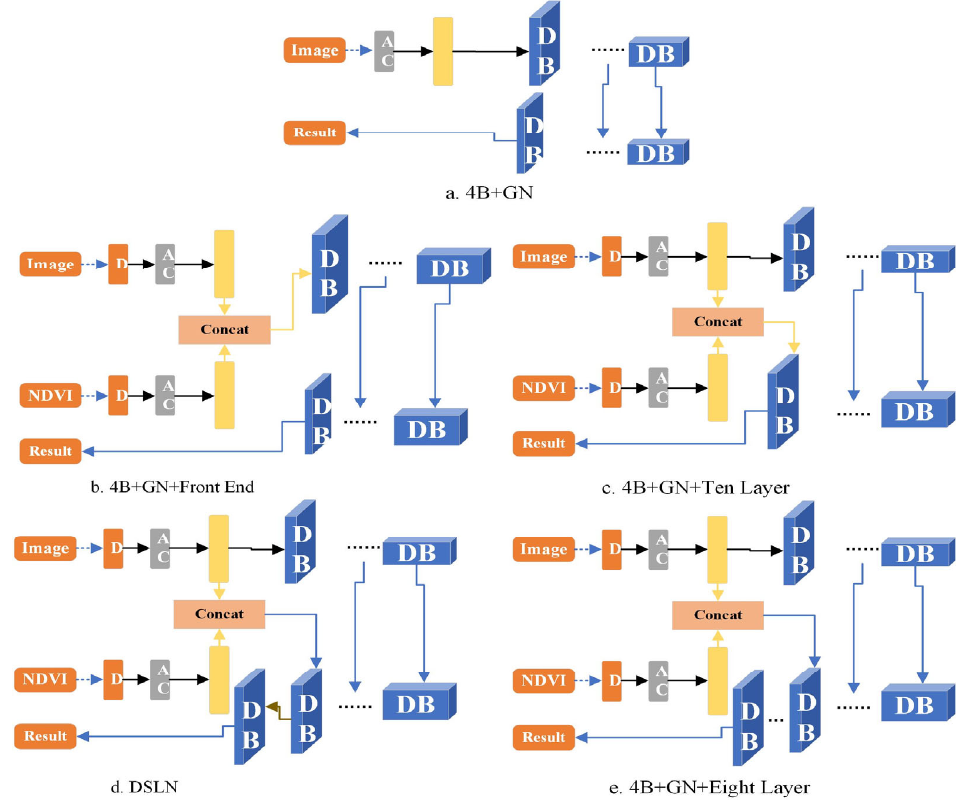
Figure 4. Different ways to realize NDVI fusion and utilization in the network.